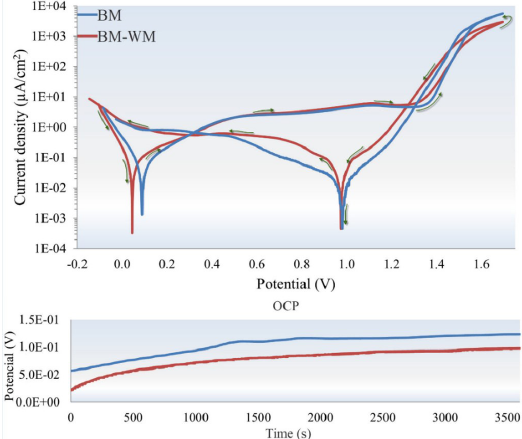
Figure 7. Cyclic polarization curves in BM and BM-WM samples in NaCl 3.5% solution (20 ± 2 °C, 1 mV/s), and their corresponding OCP. Table 3. Mean values and standard deviations of the repassivation potential ( E ( i